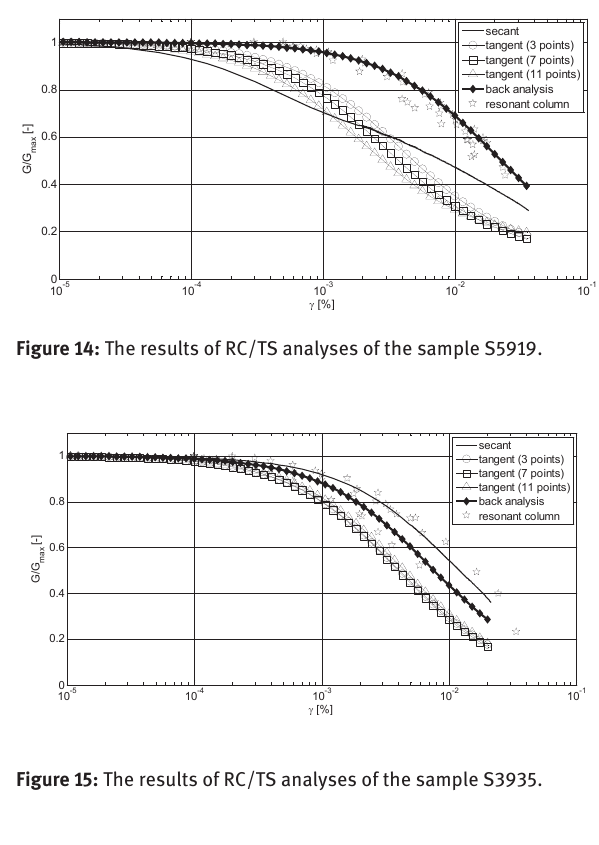
Fig. 13. The results of RC/TS analyses of the sample S3057.